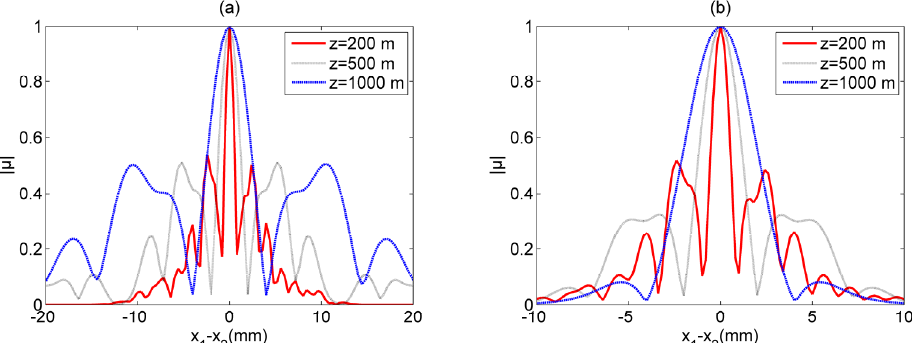
= Q = Q for the different for the different